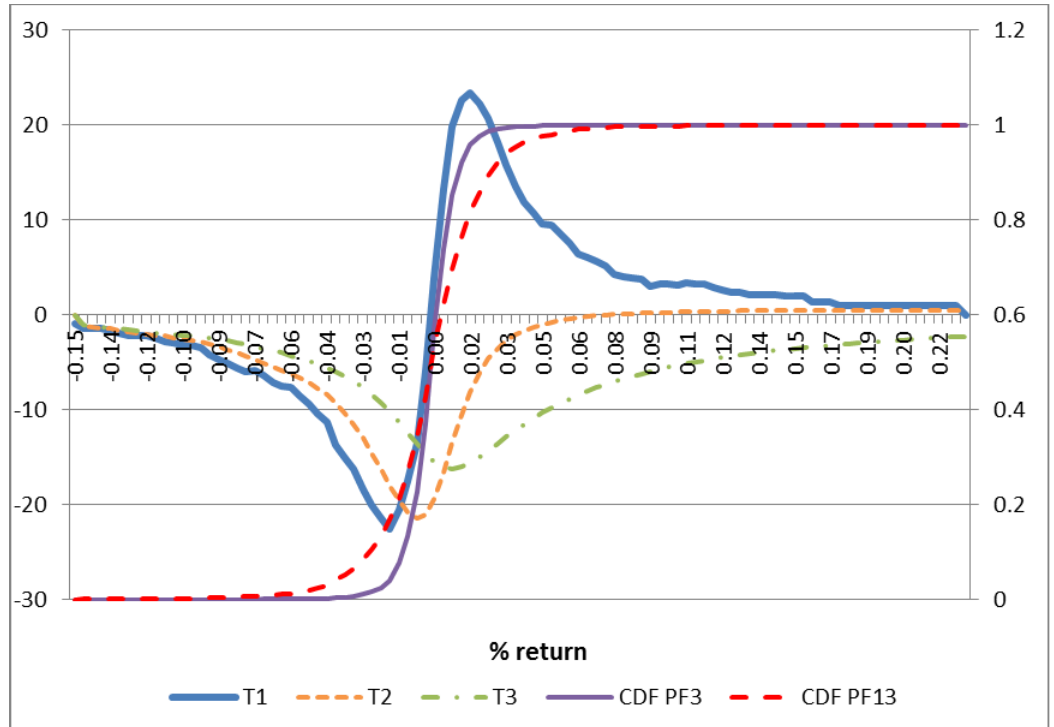
Figure 3. Plot of the CDF of the daily returns of the third domestic diversified portfolio (DOD3) and the 13 international diversified portfolios (IND13) and their DD